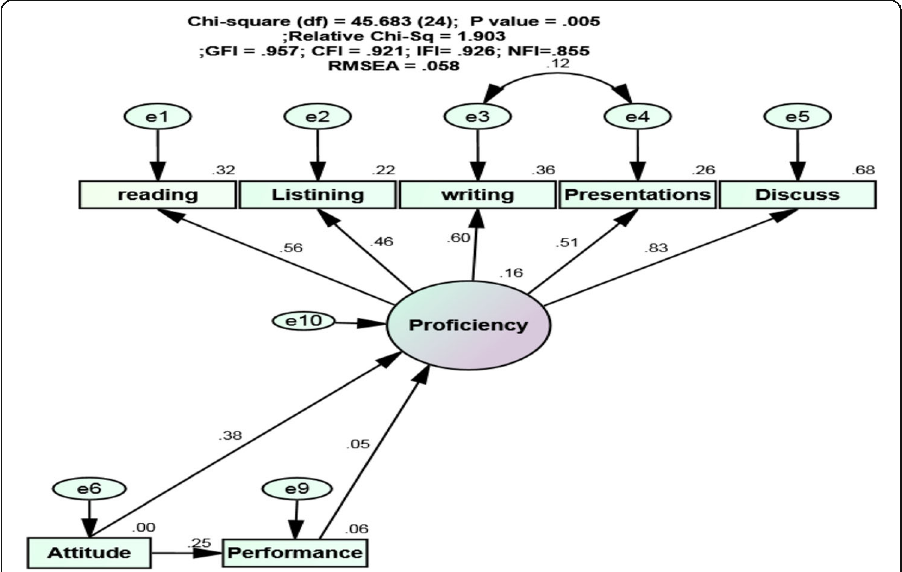
Fig. 6 Testing the effect of variables on performance for a group that they passed current English Aviation courses1, 2 based on standard